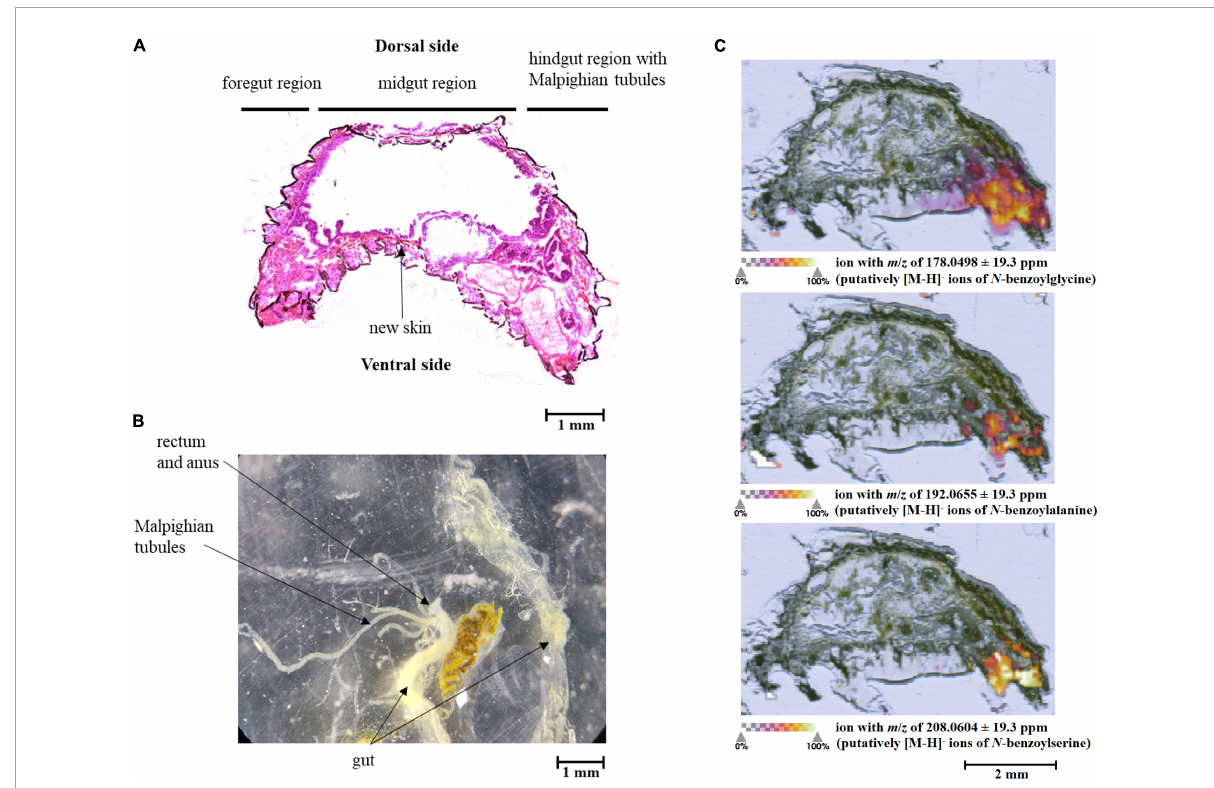
FIGURE3 Schematic representation of a Galeruca tanaceti 3rd instar larva showing a (A) stained tissue cross-section, (B) dissected gut, and (C) MALDI-Orbitrap MSI of tissue cross-sections. The larva was fed for 3 h with a cabbage leaf disc treated with benzyl glucosinolate. The abundance of the putative breakdown metabolites ( m / z of 178.0498: putatively [M-H] - ions of N -benzoylglycine; m / z of 192.0655: putatively [M-H] - ions of N -benzoylalanine; m / z of 208.0604: putatively [M-H] - ions of N -benzoylserine) is highlighted in colour. The more intense the colour, the more ions of the putative breakdown metabolites could be